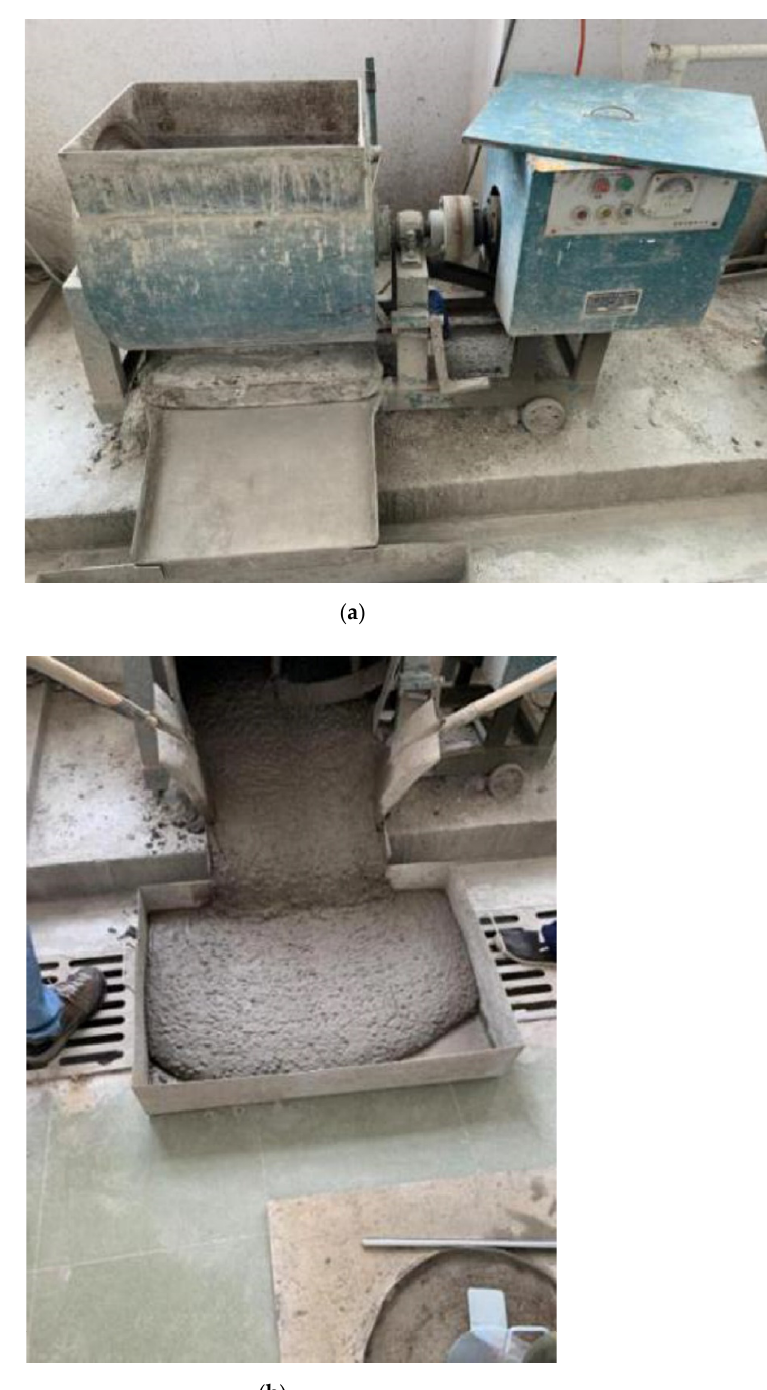
Figure 1. Photos of ( a ) single horizontal-axis forced concrete mixer and ( b ) finished SCC mixture. Table 1. Performance index of each raw material.